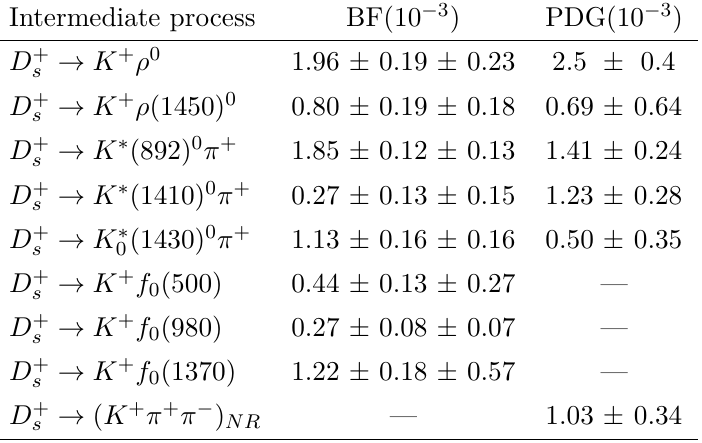
Table 11 . The BFs for various intermediate processes decaying into the final state K + π + π − in this analysis and from the PDG [2], where the first and second uncertainties are statistical and systematic,